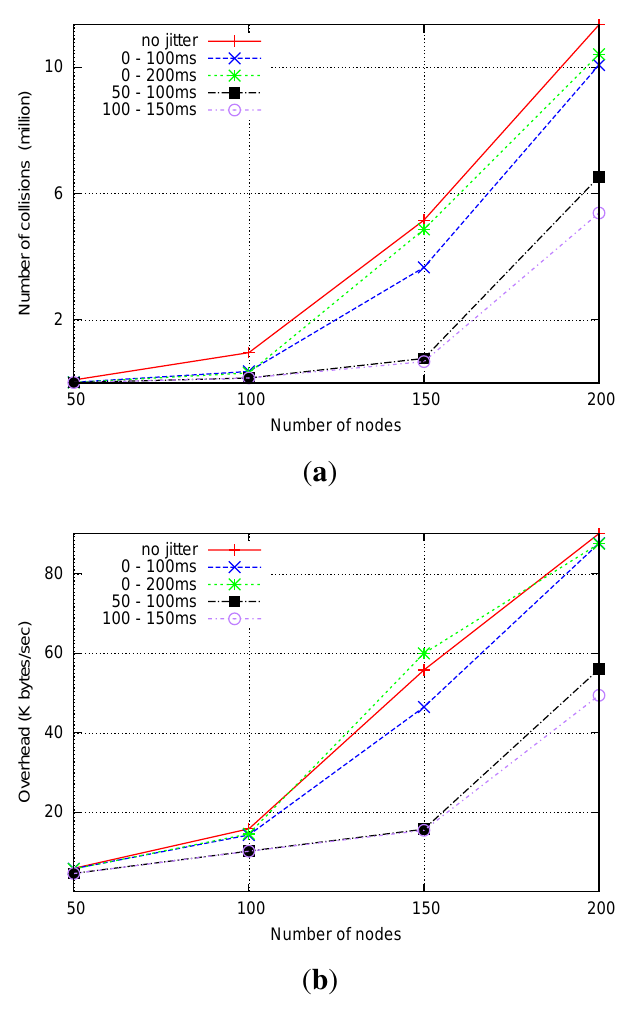
Figure 16. Simulation results of shortest-path RREQ forwarding. ( a ) Number of collisions; ( b ) Average